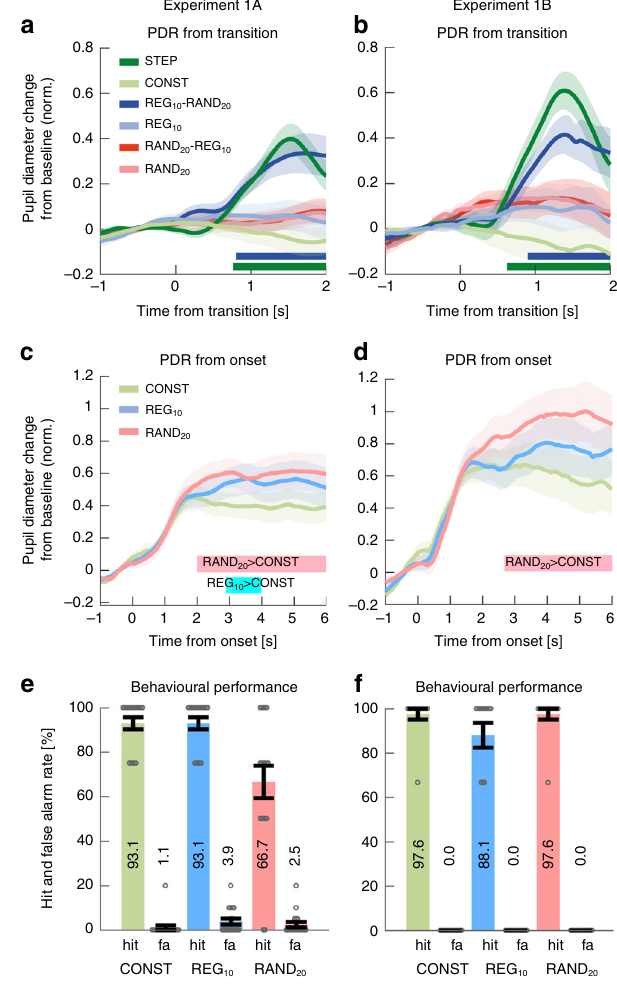
Brain response (MEG and EEG) data suggest that while REG 10 - RAND 20 and RAND 20 -REG 10 transitions are characterized by opposite statistics (emergence vs. violation of regularity; see also Supplementary Fig. 1 for an information theoretic characteriza- tion of the sequences 28 ), both are detected automatically, and at a similar latency even when participants ’ attention is directed elsewhere 22,24 . When asked to respond behaviorally to transi- tions, listeners exhibit ceiling performance and similar reaction times with comparable variability 22 (also replicated here in Exp3A). Thus, these signals are well suited for dissociating transitions associated with model resetting from those associated with model updating and provide an elegant method for disambiguating the role of the pupil-linked LC-NE system in tracking statistics of rapidly evolving sensory signals. To control for overall engagement 29 and ensure broad attention to the auditory stimuli, but without requiring active tracking of the transitions, naïve participants (in Exps 1, 2, and 4) detected short silent gaps as they listened to the tone-pip sequences. Gap occurrence was uncorrelated to state transition, and the subset of sequences containing gaps were excluded from analyses. (In Exp3 we investigate the effect of making the transition task-relevant). Exp1A ( n = 18): Fig. 2a plots the average pupil size data across all participants as a function of time relative to the transition. Clear PDRs were observed in the STEP and REG 10 -RAND 20 conditions, but not in the RAND 20 -REG 10 condition.